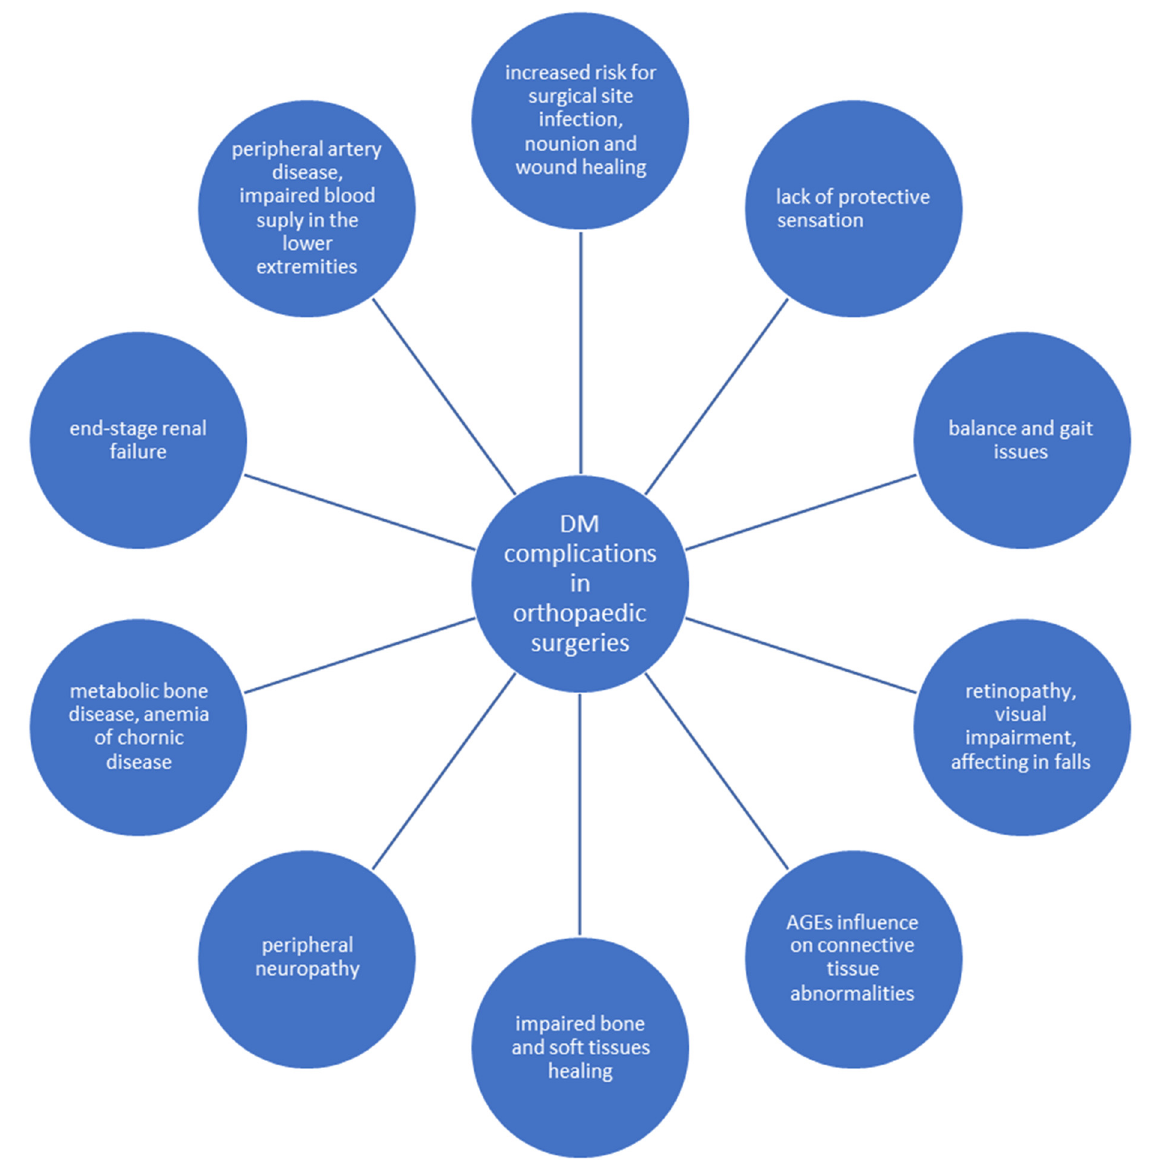
Figure 1. Potential impact of DM complications on patients undergoing orthopaedic surgeries